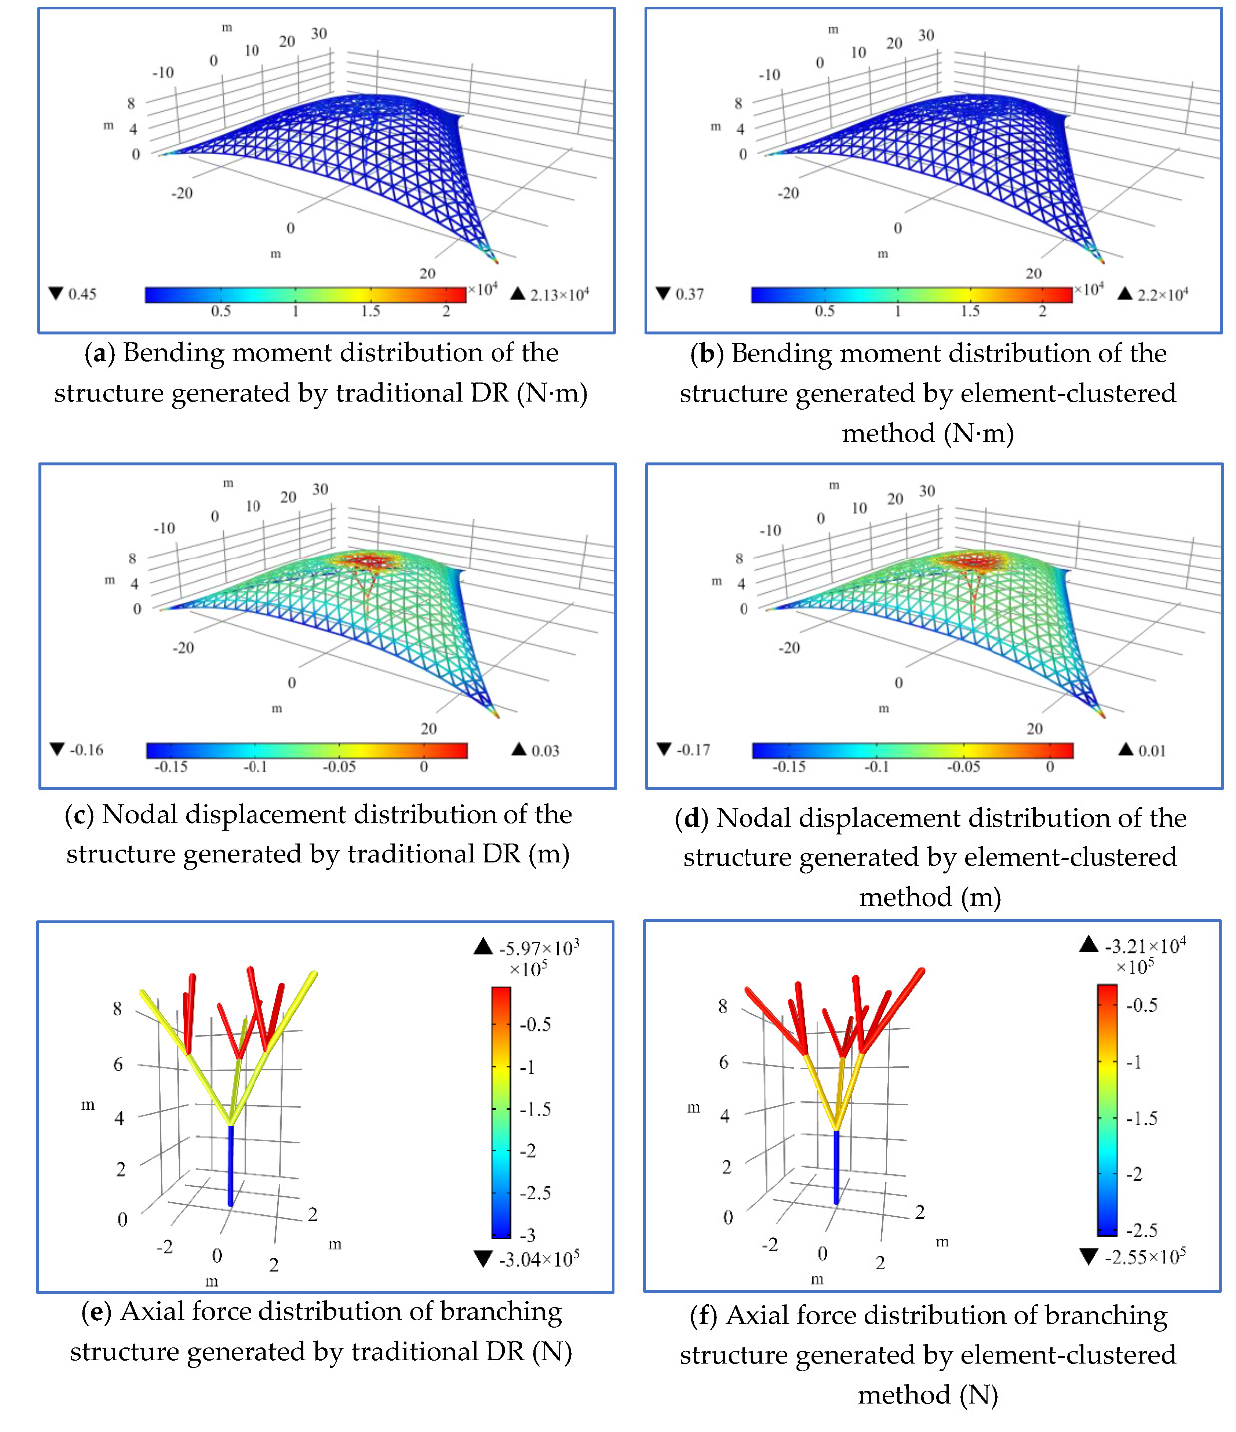
Figure 5. Comparison of mechanical properties of form-found structures. Bending moment distributions of the structures generated by ( a ) traditional DR method and ( b ) element-clustered method; Nodal displacement distributions of the structures generated by ( c ) traditional DR method and ( d ) element-clustered method; Axial force distributions of branching structures generated by ( e ) traditional DR method and ( f ) element-clustered method.